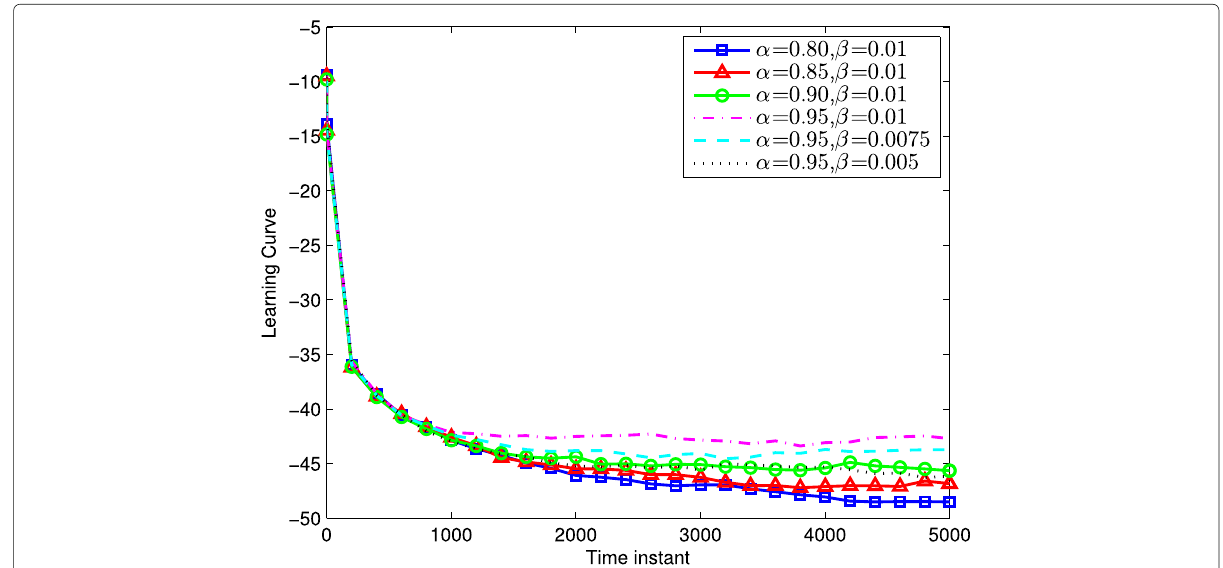
Fig. 7 Learning curves against different values of α and β for LCTVFF-DRLS algorithm when γ =